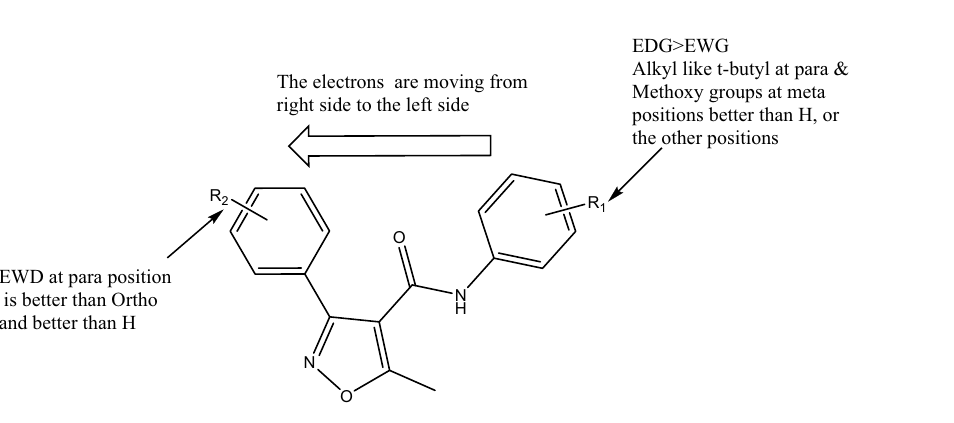
Figure 3. Structure–activity relationship of isoxazole